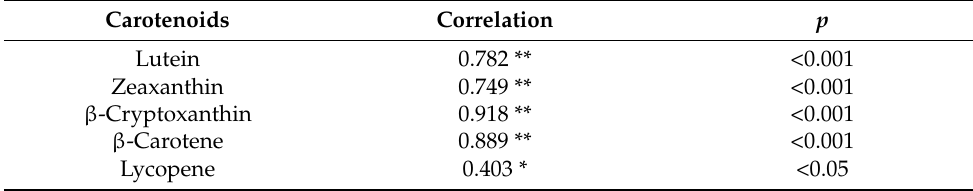
Table 3. Correlations of carotenoid levels in maternal plasma and cord plasma ( n = 30).